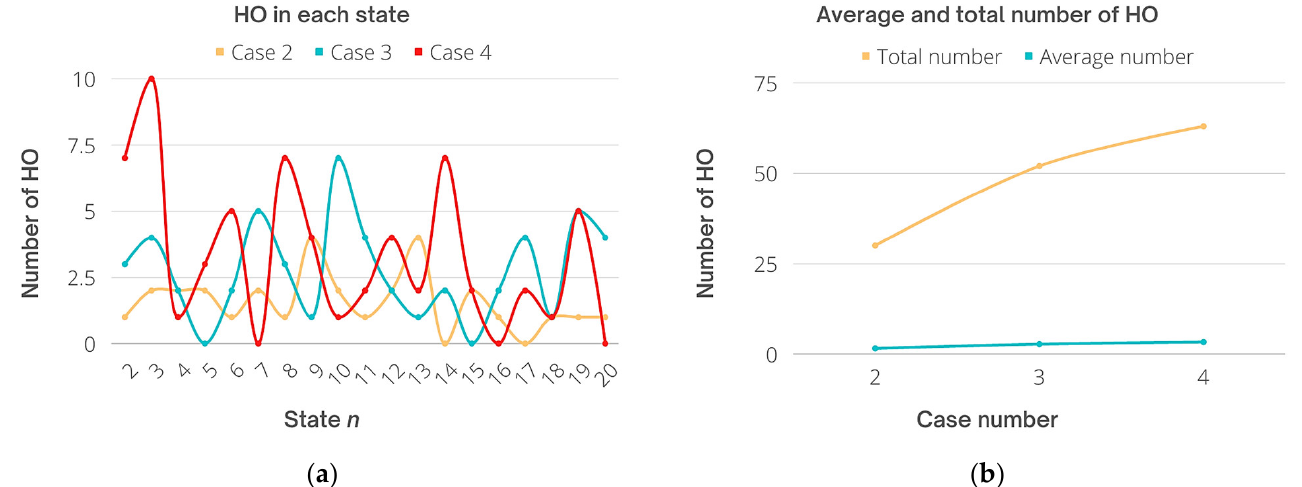
Figure 13. Statistics of HO rates. ( a ) Number of HO in each state, and ( b ) Total and the average number of each case.